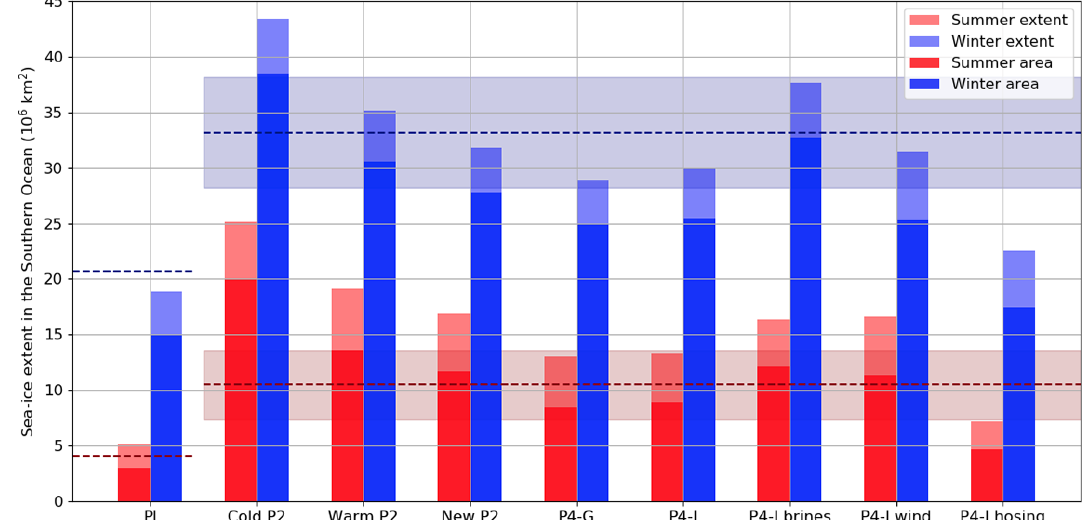
Figure 5. Austral summer (JFM) and winter (JAS) sea-ice areas and extents in the Southern Ocean. The LGM sea-ice extent estimated using the proxy data compilation is represented by the dashed red (summer) and the blue (winter) lines (with an indicative error bar of 30% and 15%, respectively). The modern values (dashed lines on the left) are mean values on the period 1979–2010 published in Parkinson and Cavalieri